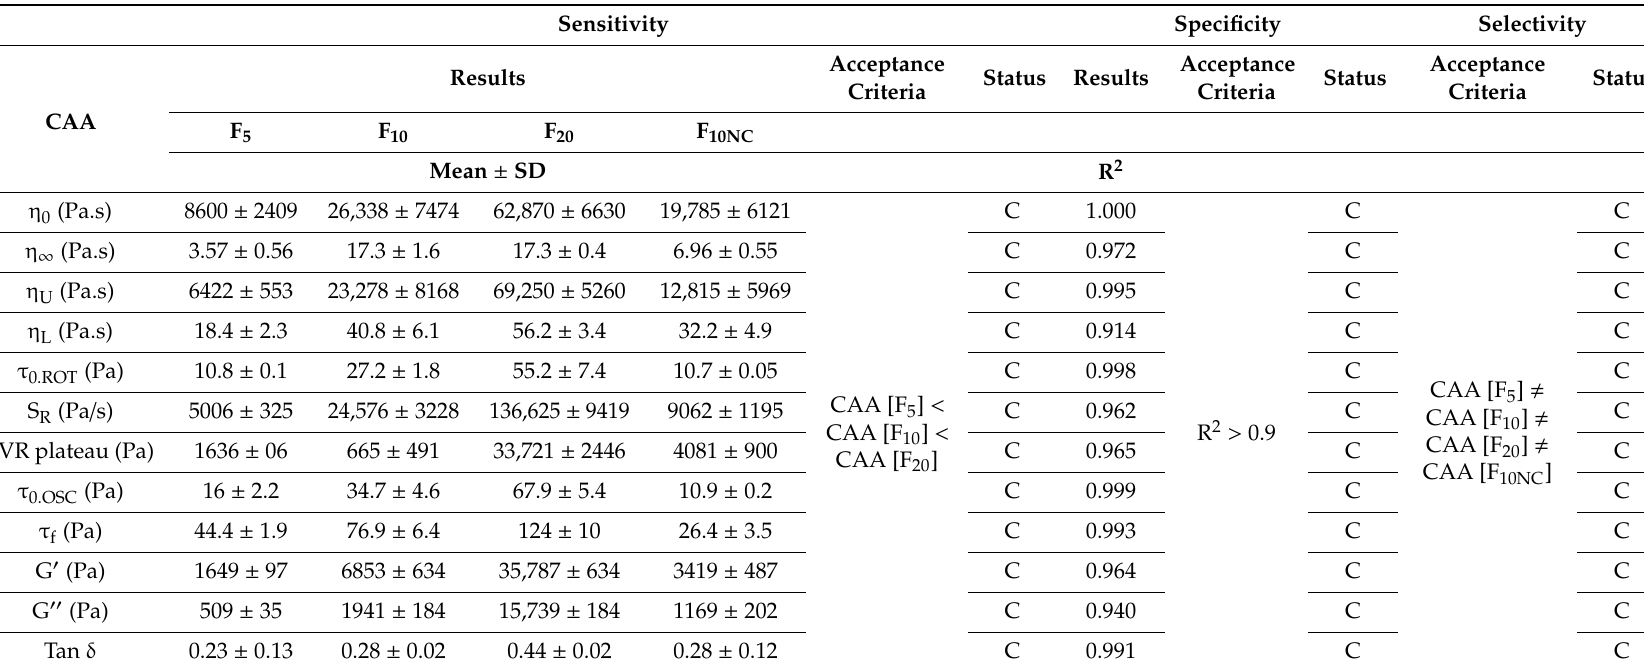
Table 4. Acceptance criteria and results of discriminatory power evaluation. Results report to mean ± SD. A 6 < n < 36 was used. Sensitivity Specificity Selectivity Acceptance Acceptance Acceptance Results Status Results Status Criteria Criteria Criteria CAA